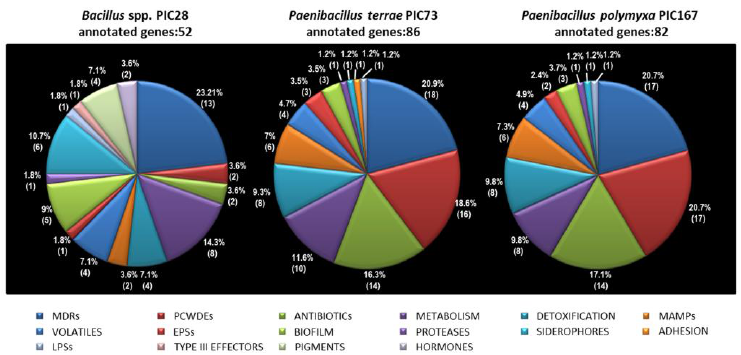
Figure 2. Number of genes and percentage of genetic factors involved in plant-bacteria interaction detected in the genomes of the olive rhizobacteria PIC28, PIC73 and PIC167. Table 5. Genetic factors involved in plant-bacteria interaction identified in the genomes of the Bacillales strains PIC28, PIC73 and PIC167, according to the web-based tool ‘PIFAR’ [47].